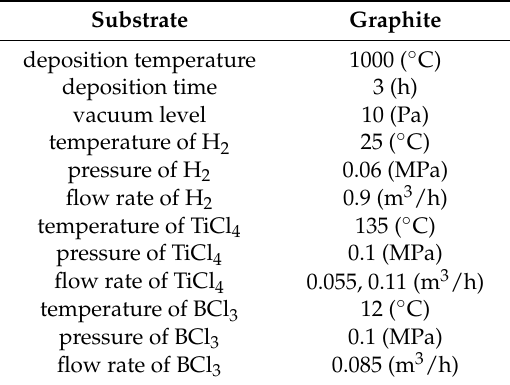
Table 1. Field of deposition